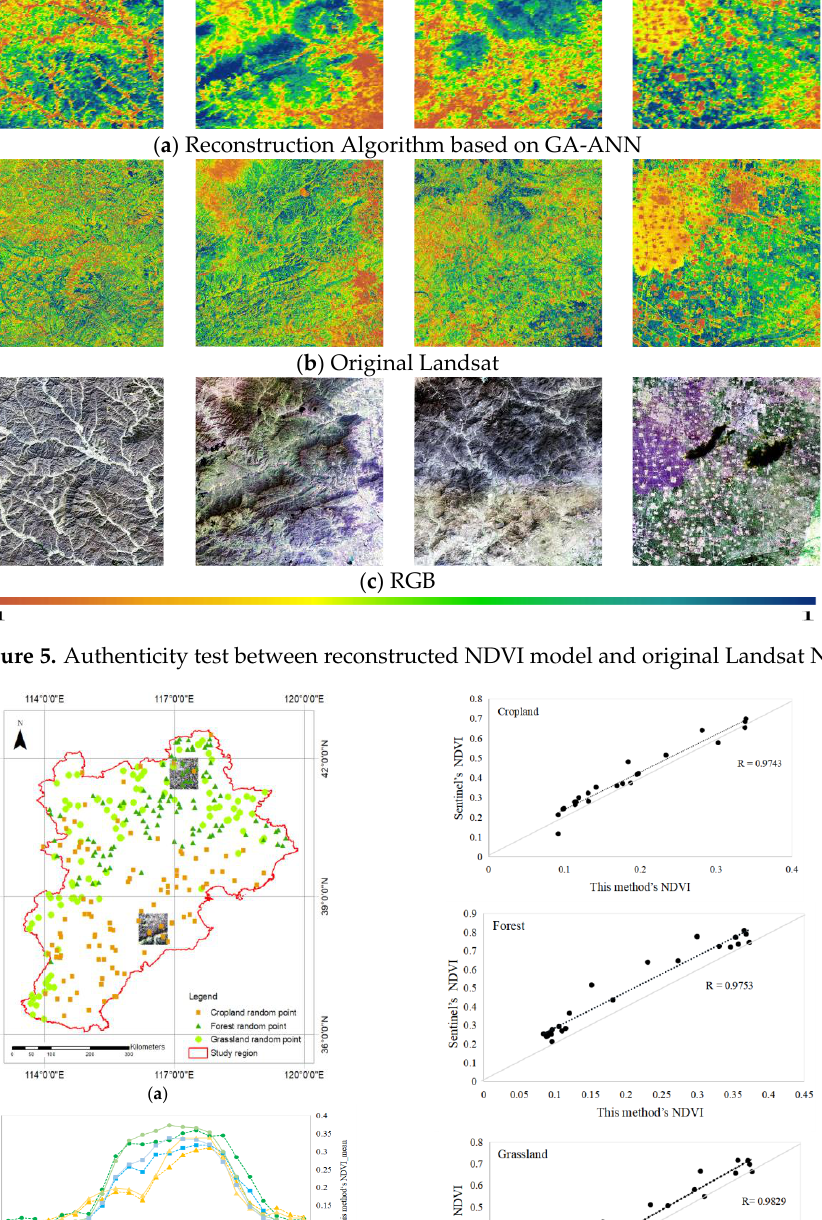
paper's method with Sentinel NDVI for different vegetation types. and true-color image distribution. ( b ) Change in the mean value of NDVI. ( c ) Comparison of this